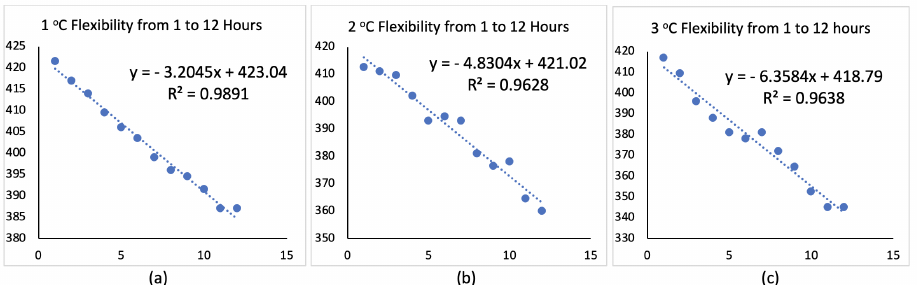
Figure 6. Linear approximation for the flexibility services from 1 to 12 h. In ( a ) is computed for 1 ◦ C change, in ( b ) for 2 ◦ C change, and in ( c ) for 3 ◦ C change.